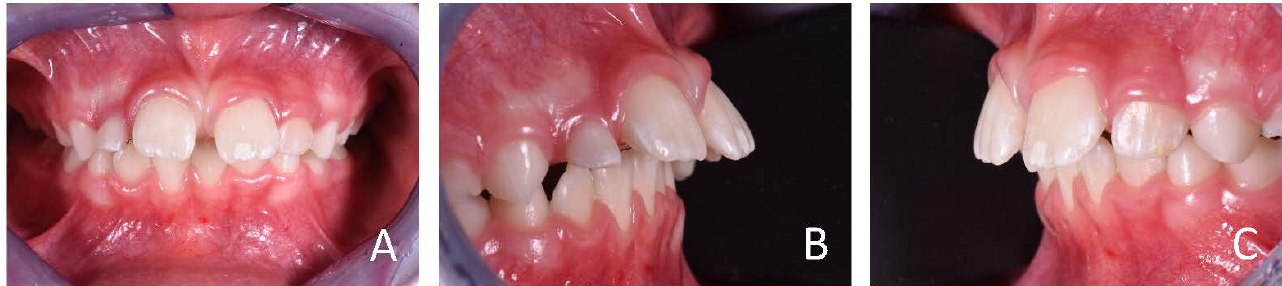
Figure 21. Intraoral photographs of the subject before the treatment (7-year-old). ( A ) Frontal view; ( B , C ) lateral view.